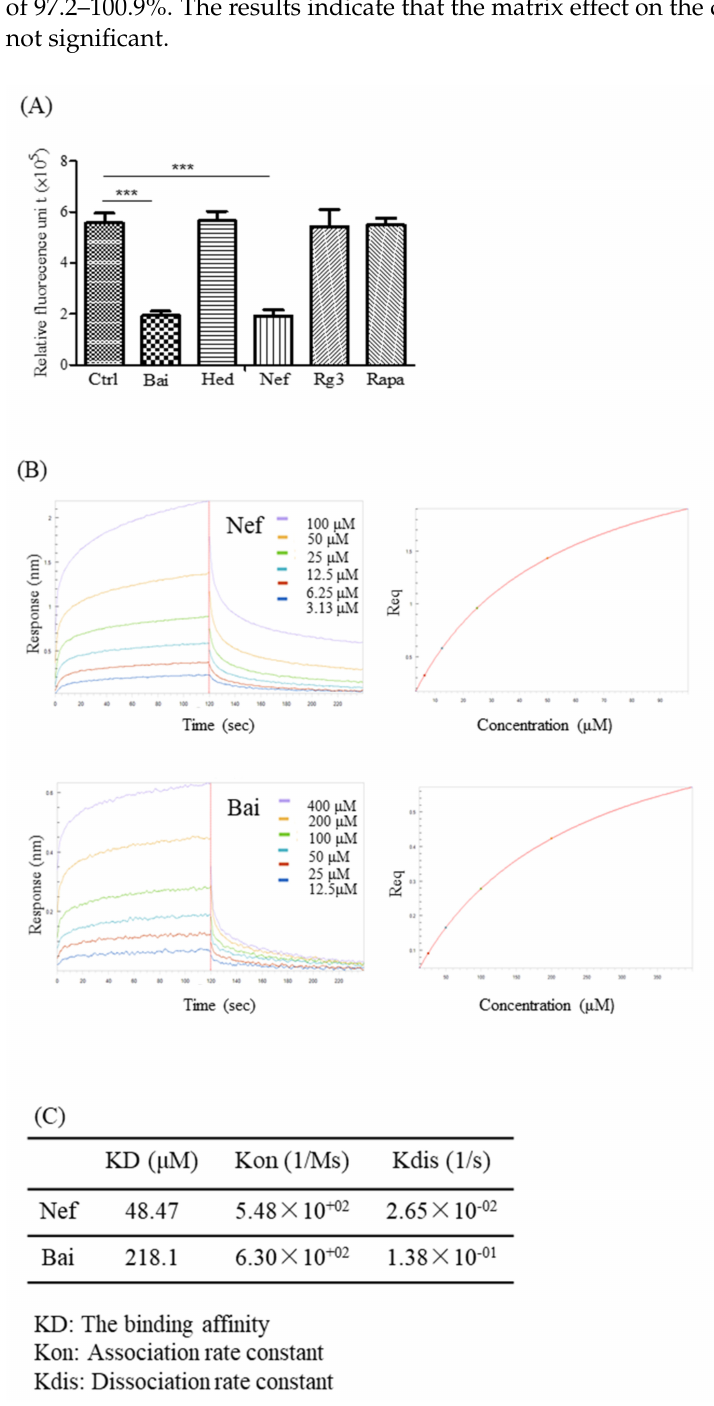
Figure 6. The validation of the A β -binding propensity of the compounds by ThT and BLI. ( A ) The inhibitory effect of the five selected natural compounds on fibrillation of A β (1–42) (the concentrations of Bai, Hed, Nef, Rg3 and Rapa were 50 µ g/mL, 2 µ g/mL, 0.5 µ g/mL, 50 µ g/mL and 150 ng/mL) were measured by ThT fluorescence intensity detection. All of the experiments were performed as three independent experiments. ( B ) Representative kinetic binding sensorgrams of increasing concentrations of Nef and Bai from 3.13 µ M to 100 µ M or 12.5 µ M to 400 µ M, respectively, were shown with real-time data acquisition for each step of the kinetic assay. ( C ) The optimal binding concentrations of the two herbal compounds (Bai and Nef) to A β (1–42) were 218.1 µ M and 48.47 µ M. One-way ANOVA was used to compare the data: *** p <